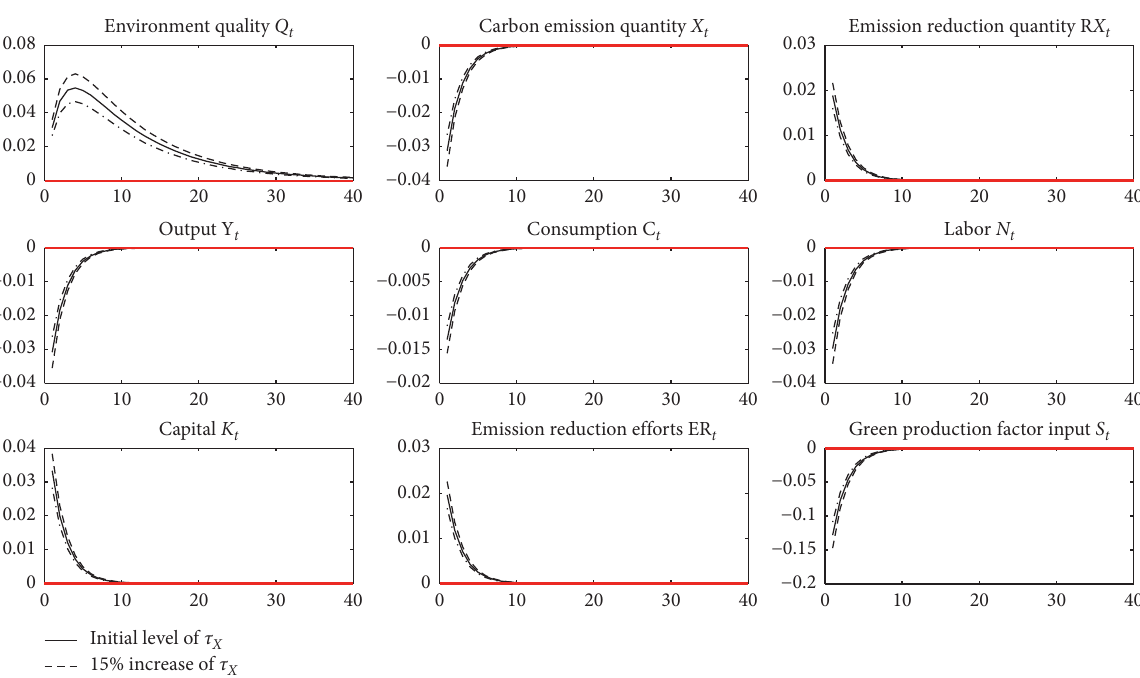
Figure 5: Sensitivity analysis on carbon tax